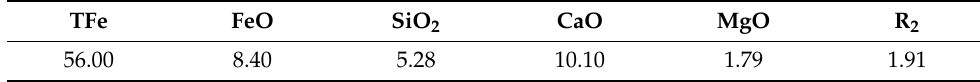
Table 1. Composition of the sinter used in this work (wt%).